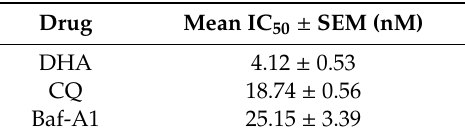
Table 2. IC 50 values of DHA / CQ / Baf-A1 against P. f 3D7 in vitro.